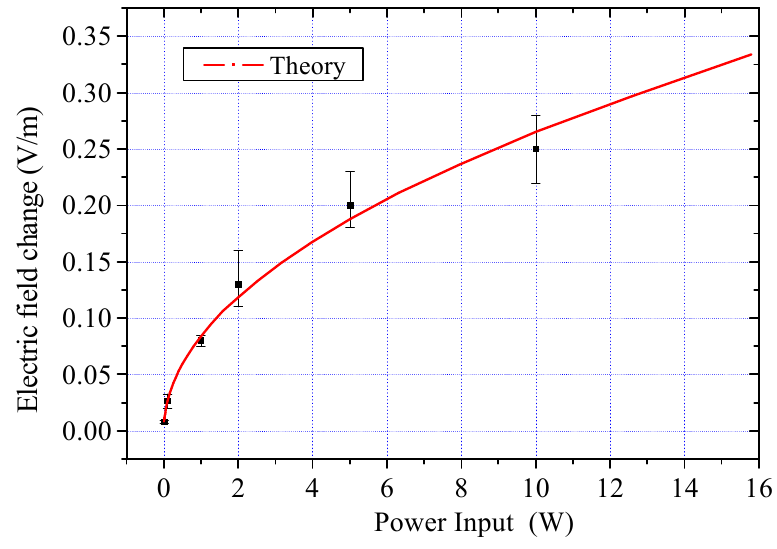
Figure 5 . Relationship between the E-field changes and the power inputted.